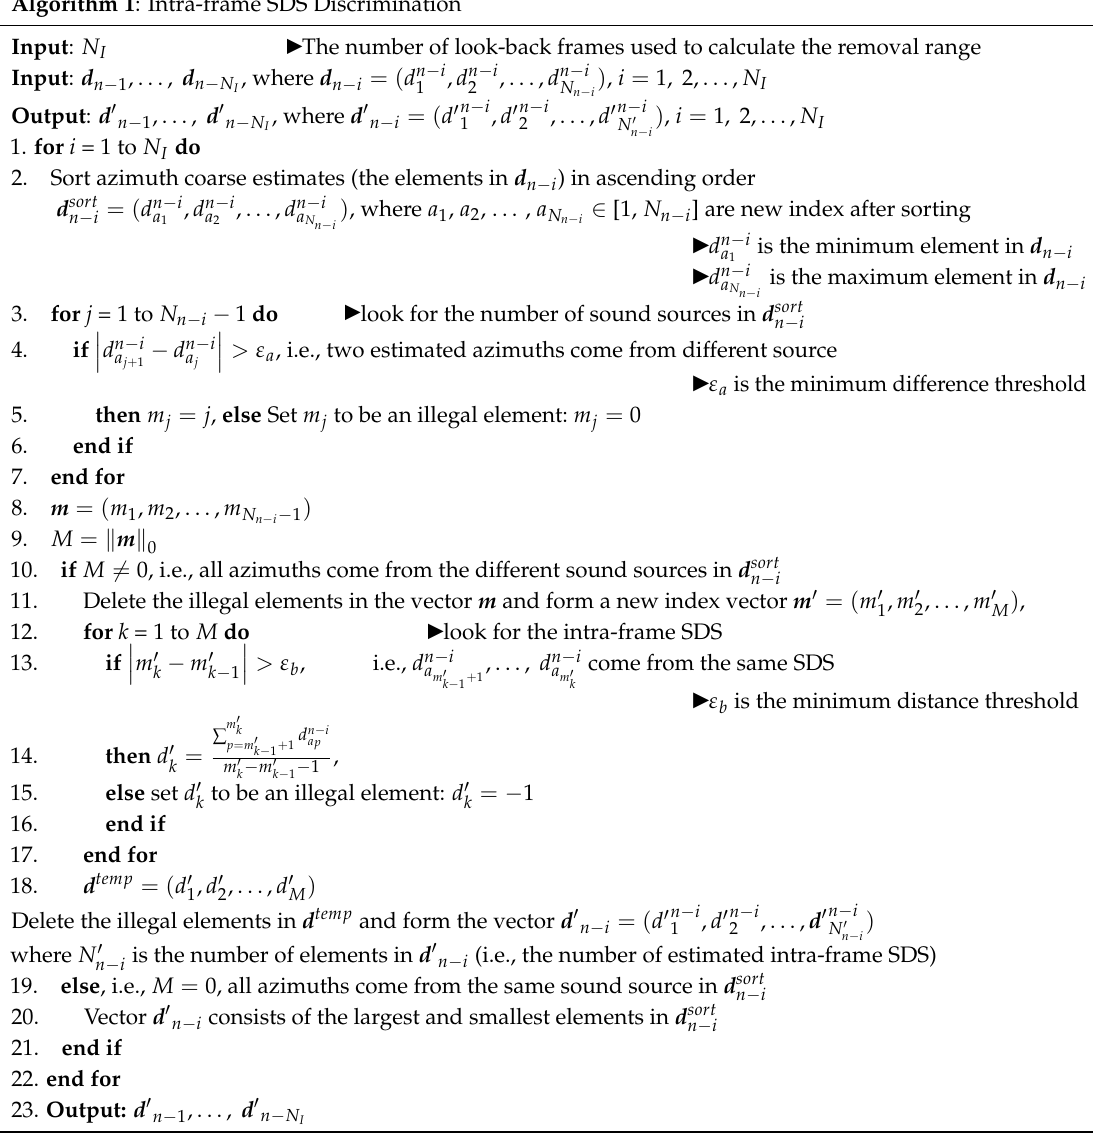
Algorithm 1 : Intra-frame SDS Discrimination